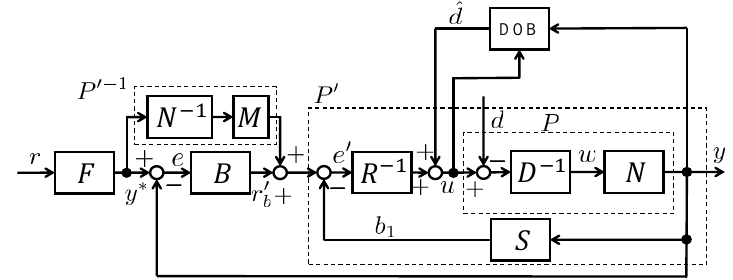
Figure 12. Proposed